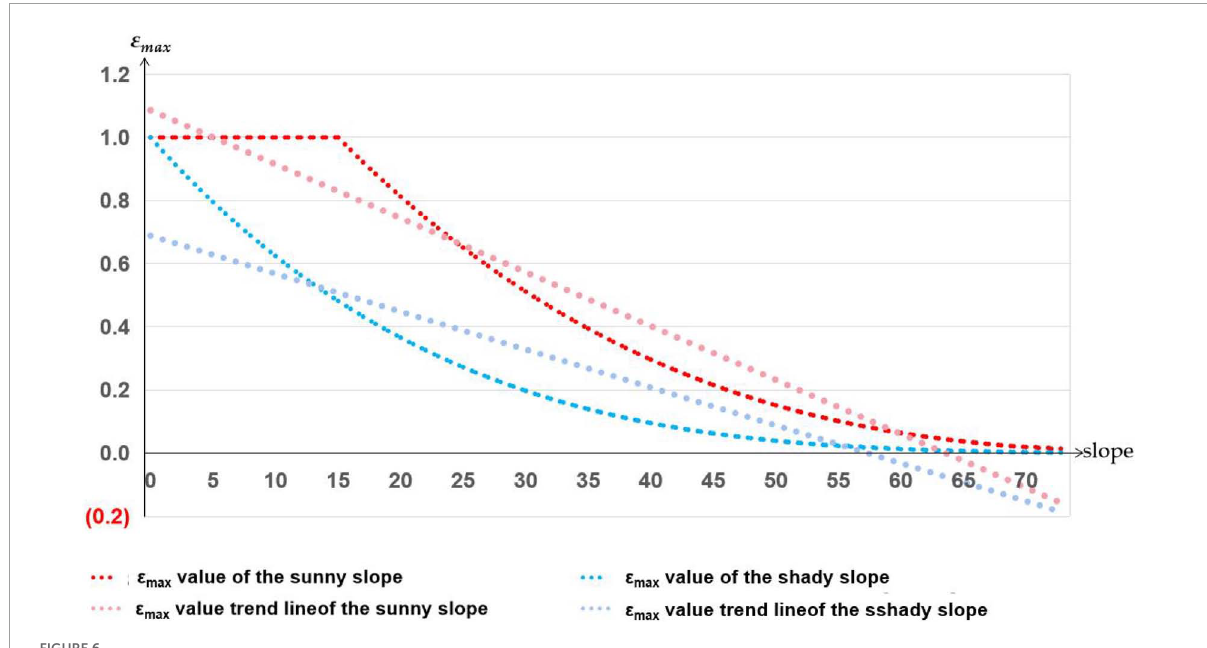
FIGURE6 Relationship between slope and ε max